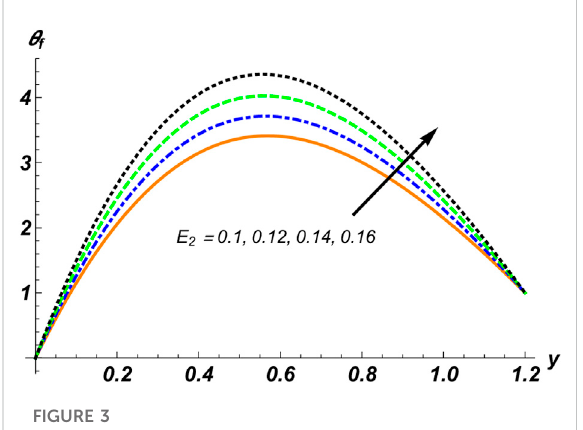
Temperature pro fi le for various values of Ec .